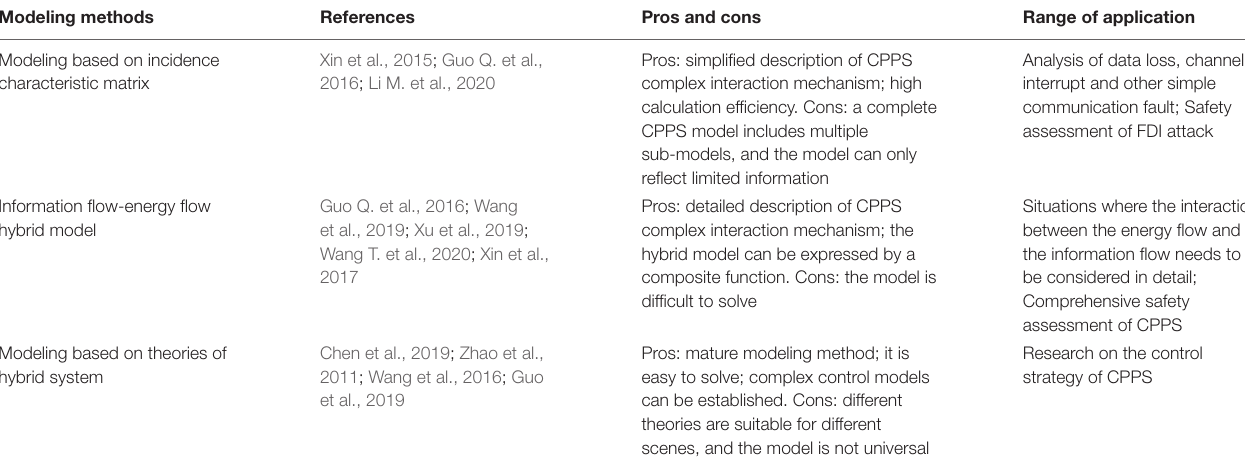
TABLE 1 | Comparison of CPPS modeling